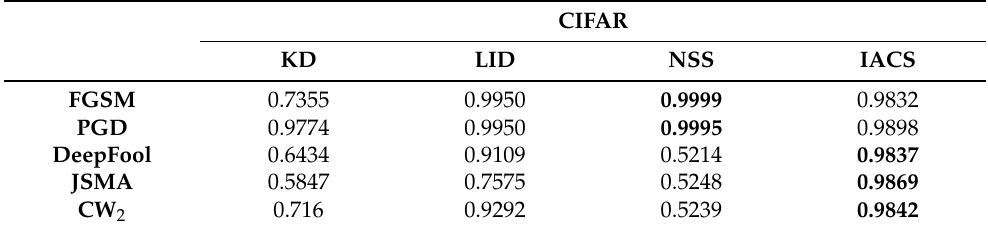
Table 3. The AUC score of different detection methods including the KD-based method, the LID- based method, the NSS-based method, and the IACS-based (our method) method on the CIFAR10 dataset. The best results are highlighted in